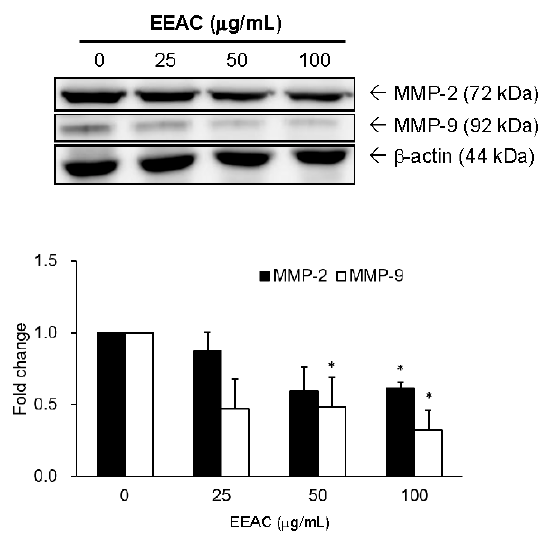
Figure 4. Suppression effect of EEAC on gelatinases in A549 cells. The expression levels of gelatinases, MMP-2 and MMP-9, were examined in A549 cells incubated with various concentrations of EEAC for 24 h. The band intensities of each group were quantified and normalized to the control group, and the relative expressions of gelatinases were presented as fold change in a histogram. * p < 0.05 compared to the control group (treated with vehicle alone).